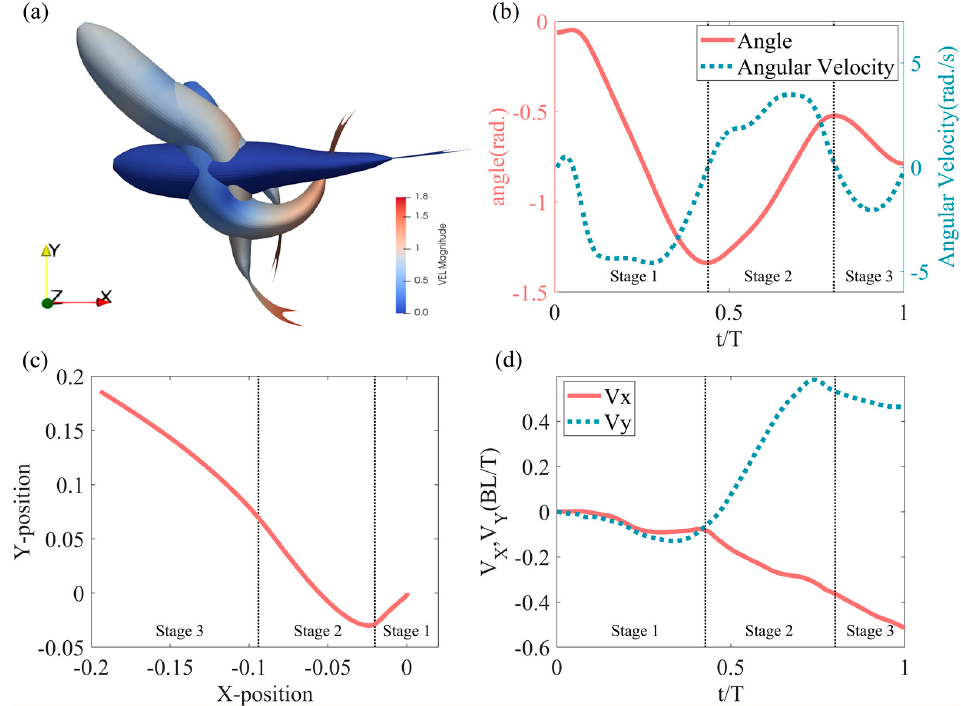
Figure 5. ( a ) Snapshots of the fish at t/T = 0, 0.43 (end of stage 1), 0.76 (end of stage 2), and 1. ( b ) The time course of heading angle and angular velocity. ( c ) Translational motion. ( d ) Translational velocity. The black dotted line is the stage separation line.